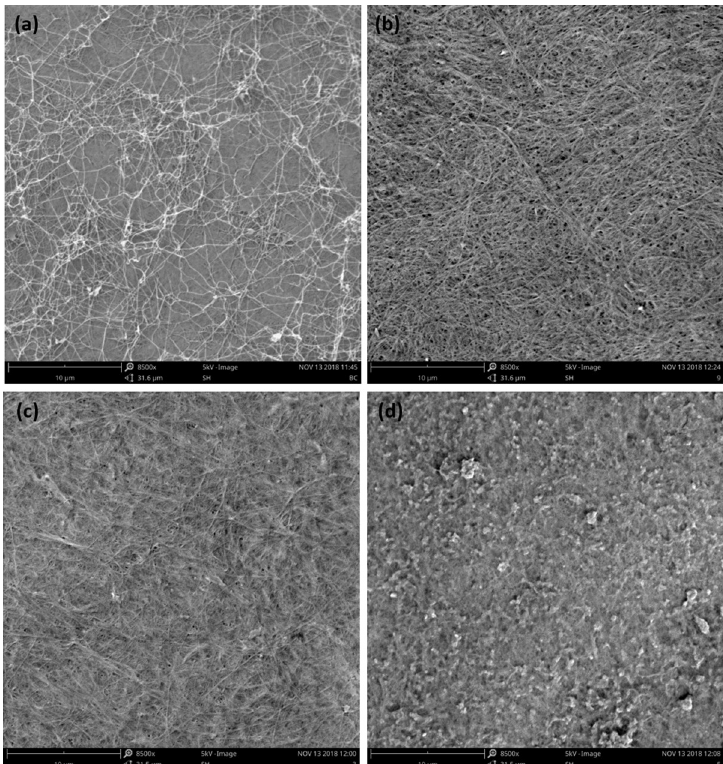
Fig 5. SEM photographs (x 8500) of BC samples coated with polyaniline: (a) bleached BC; (b) aniline + HBT + without laccase; (c) aniline + laccase + without HBT; (d) aniline + laccase + HBT; the samples were all incubated in a water-bath (WB).